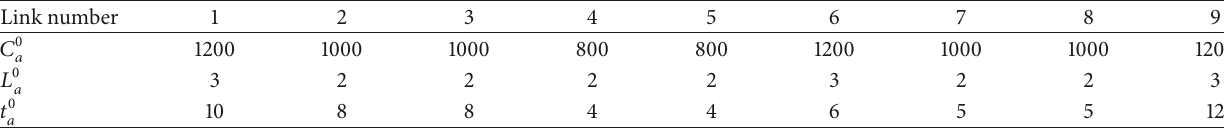
Table 2: The detailed link parameter setting.